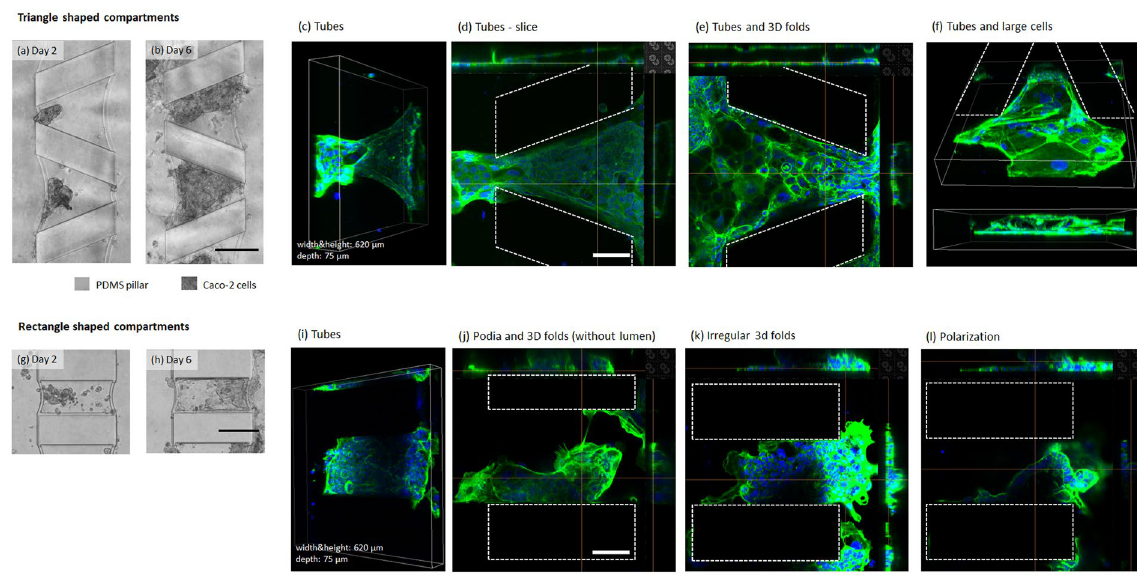
Figure 3. ( a , b,g,h ) Top-view phase contrast microscopy images of Caco-2 cells cultured under 300 µ l h − 1 flow rate in compartments with various sizes and shapes. ( a,b ) Triangular compartments and ( g,h ) rectangular compartments on days 2 and 6. Scale bars are 250 µ m. ( c–f, i–l ) Top and 3D views of confocal microscopy images. Caco-2 cells cultured in ( c–f ) triangular shaped and ( i–l ) rectangular shaped compartment designs under 300 µ l h − 1 flow rate of culture medium. DAPI and GFP represent cell nuclei and actin filaments, respectively. Cells forming tubes, irregular 3D folds, and podia are shown. Scale bars are 125 µ